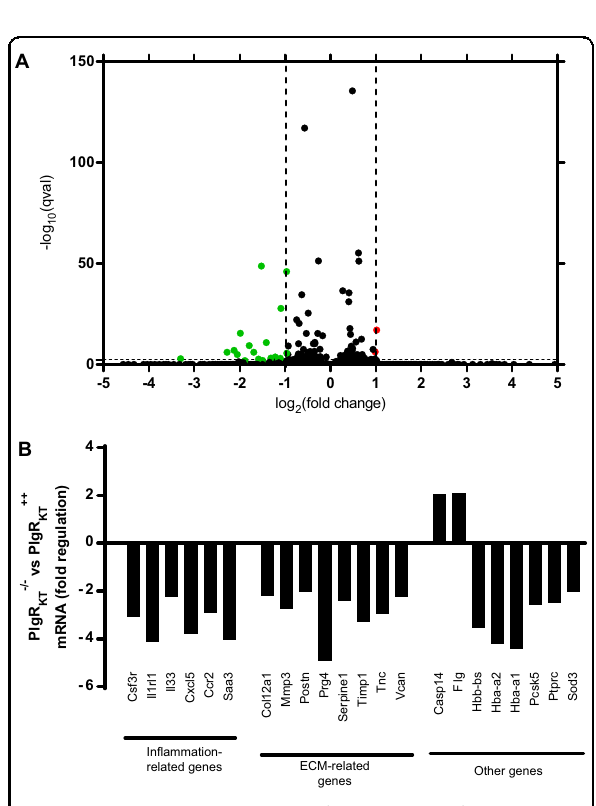
Fig. 6 Gene expression in Plg-R KT − / − and Plg-R KT + / + wound tissue. Gene expression was studied using mRNA sequencing in samples taken at day 11 ( n = 4). All the genes had corrected p value ≤ 0.05. A Volcano plots with genes upregulated>2.0-fold in Plg-R KT − / − tissue shown in red, genes downregulated <2.0-fold Plg-R KT − / − tissue shown in green and unregulated genes shown in black. B Genes whose expression changed by ≥ 1.5-fold tissue in Plg-R KT − / − tissue.